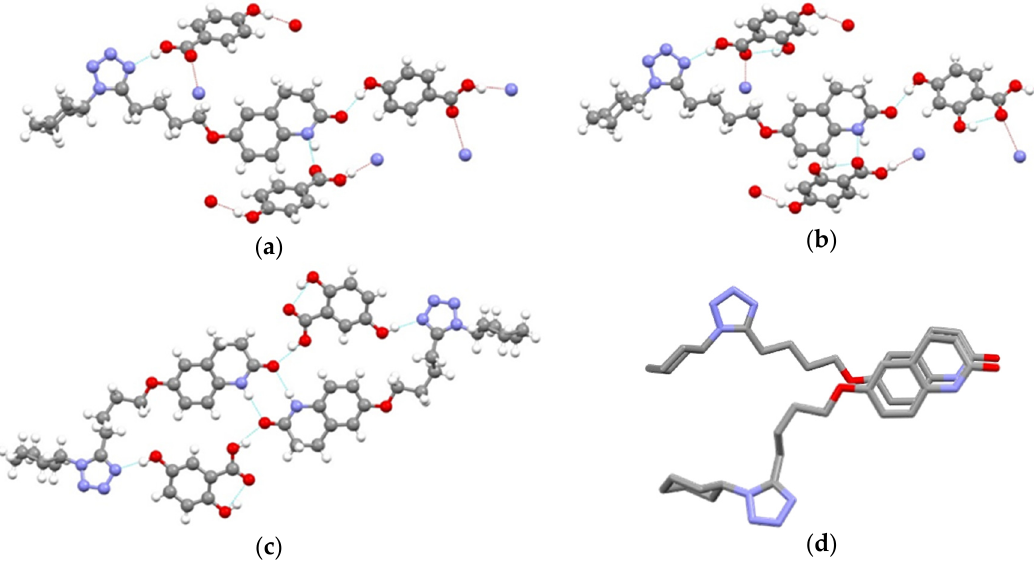
Figure 2. Crystal structures of the CLZ cocrystals; ( a ) CLZ-4HBA cocrystal, ( b ) CLZ-2,4DHBA cocrystal, ( c ) CLZ-2,5DHBA cocrystal, and ( d ) overlaid CLZ conformations in the CLZ-4HBA and CLZ-2,5DHBA cocrystals. Images were produced using Mercury ® based on a previous study [20].